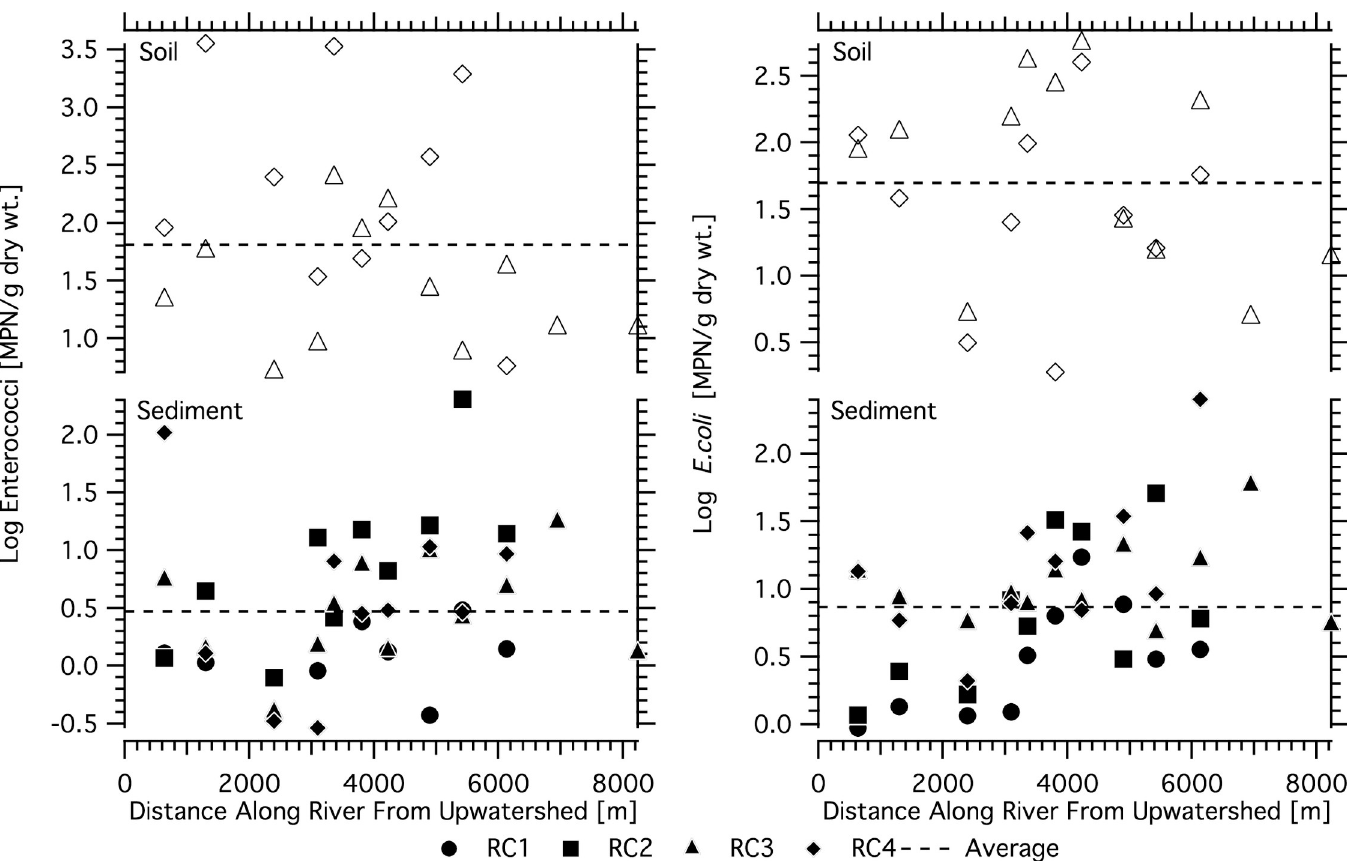
Fig 4. Spatial distribution of enterococci and E . coli in river sediments and soils of Hanalei River as a function of distance along the river from the river mouth. Soil concentrations are shown in top panels (squares) and sediments concentrations are shown in bottom panels (circles). Horizontal dashed lines represent average concentrations in their respective matrices. The distance represents the along river distance from the USGS